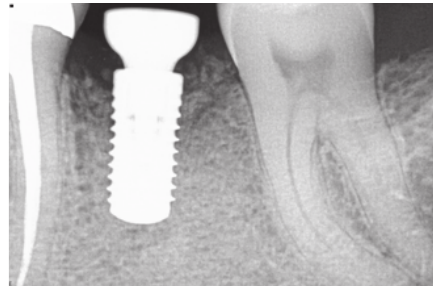
Figure18:Sixmonthsfollowinggraftingofthesitewithfreeze-dried bone allograft and a resorbable membrane.